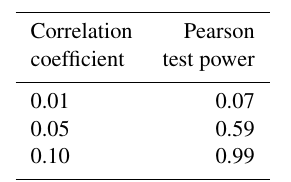
Table 3. Pearson test power for several hypothetical correlation co- efficients between φ for different EOFs.